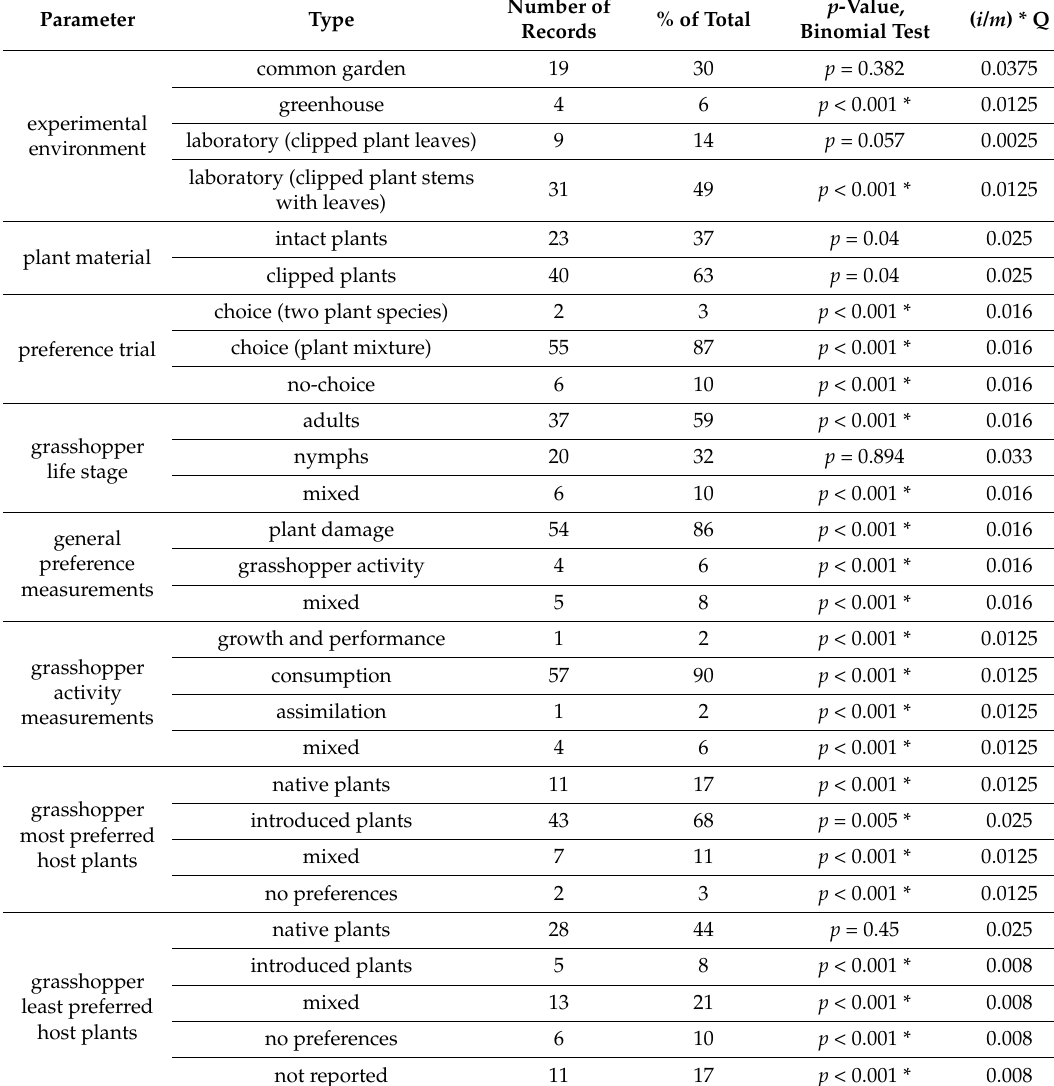
Table 1. Experimental conditions and outcomes extracted from the feeding